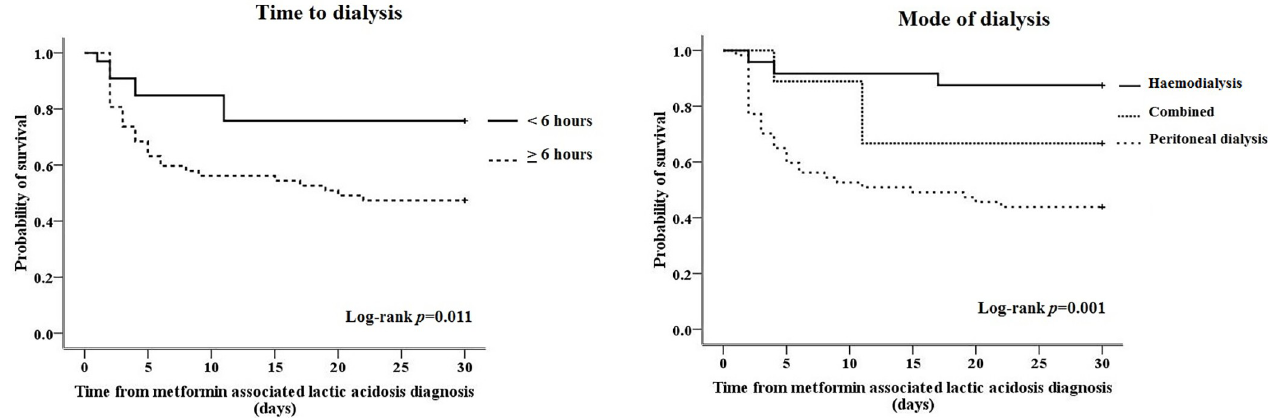
Fig 1. Kaplan-Meier survival function for patients diagnosed with metformin-associated lactic acidosis stratified by a) time to dialysis and b) mode of dialysis.